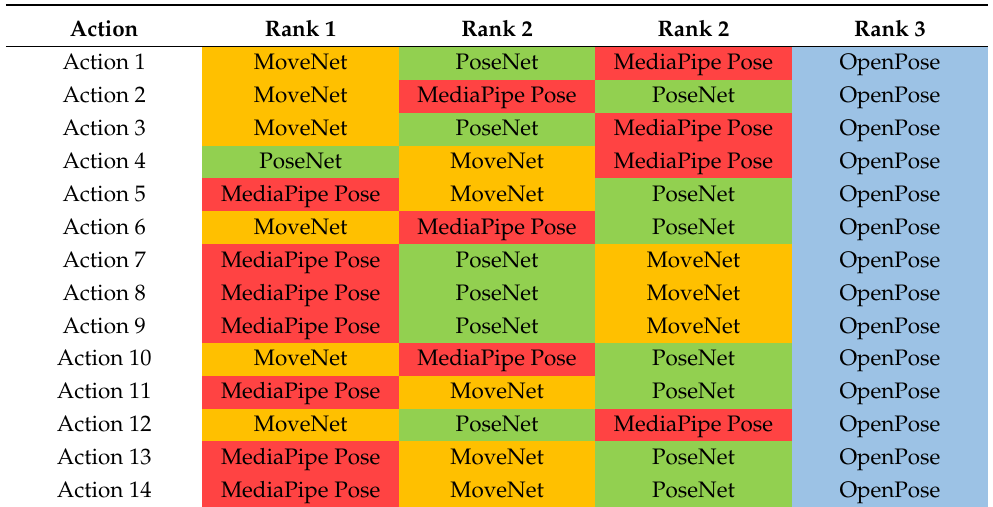
Red cells represent MediaPipe Pose. Orange cells represent MoveNet. Green cells represent PoseNet. Blue cells represent OpenPose.